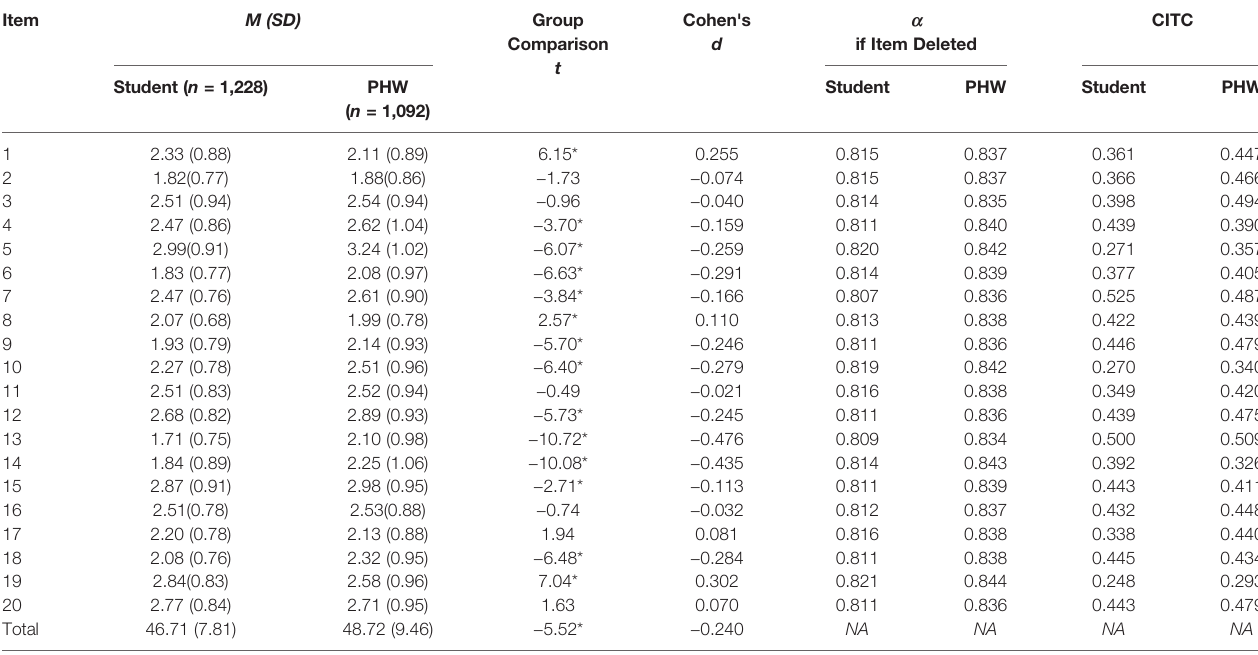
TABLE 4 | The Reliability of SF-CAMI Item and Scale Scores in Medical Students and Primary Healthcare Workers. Item M (SD) Group